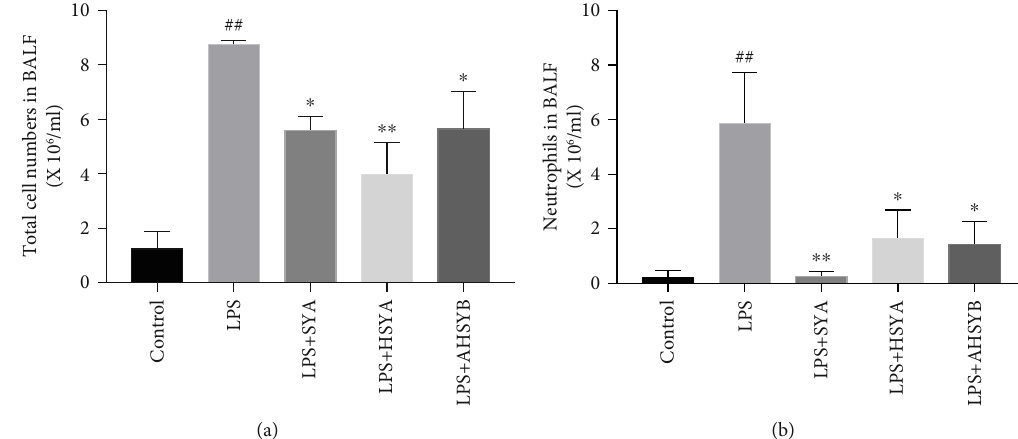
Figure 4: E ff ects of SYA, HSYA, and AHSYB on in fl ammatory cells induced by LPS. (a) The total cells detected by fl ow cytometry in BALF. (b) The neutrophils detected by fl ow cytometry in BALF. The values presented are mean ± SEM , ## P < 0 : 01 vs the control group; # P < 0 : 05 vs the control group; ∗ P < 0 : 05 vs the LPS group; ∗∗ P < 0 : 01 vs the LPS group.